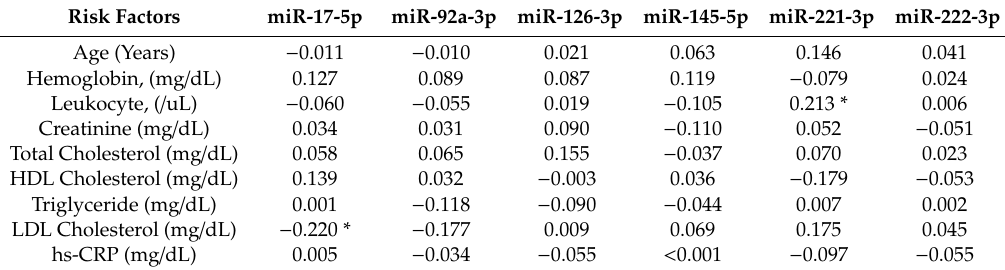
Table 2. Association between cardiovascular risk factors and miR